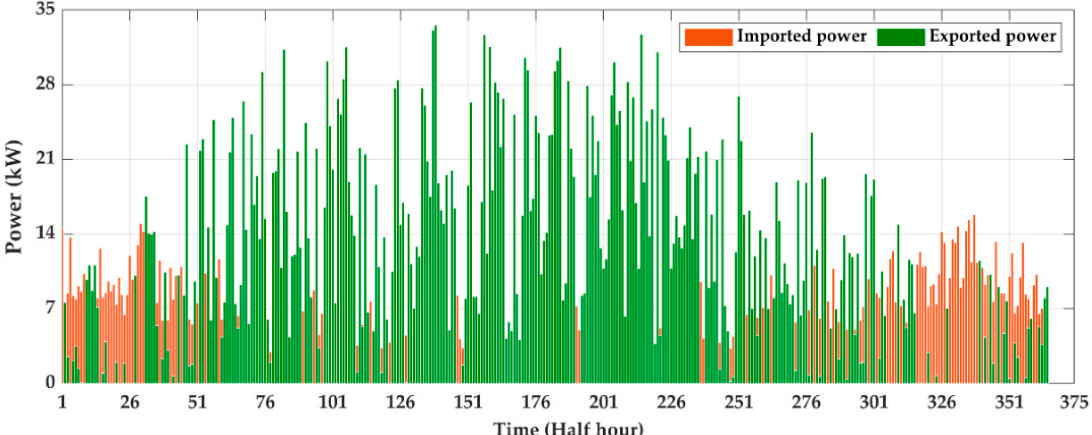
Figure 9. Imported and exported power with a PV system, grid, and BSS utilized during peak hours.